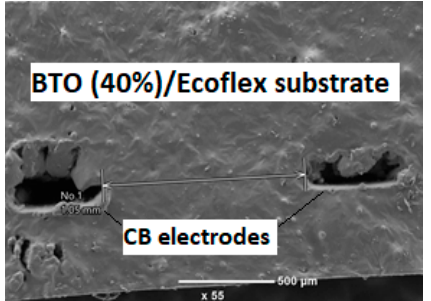
Figure 5. SEM image of a cross section of 200 nm BTO–Ecoflex TM 00-30 composite substrate and printed CB/Ecoflex electrode.